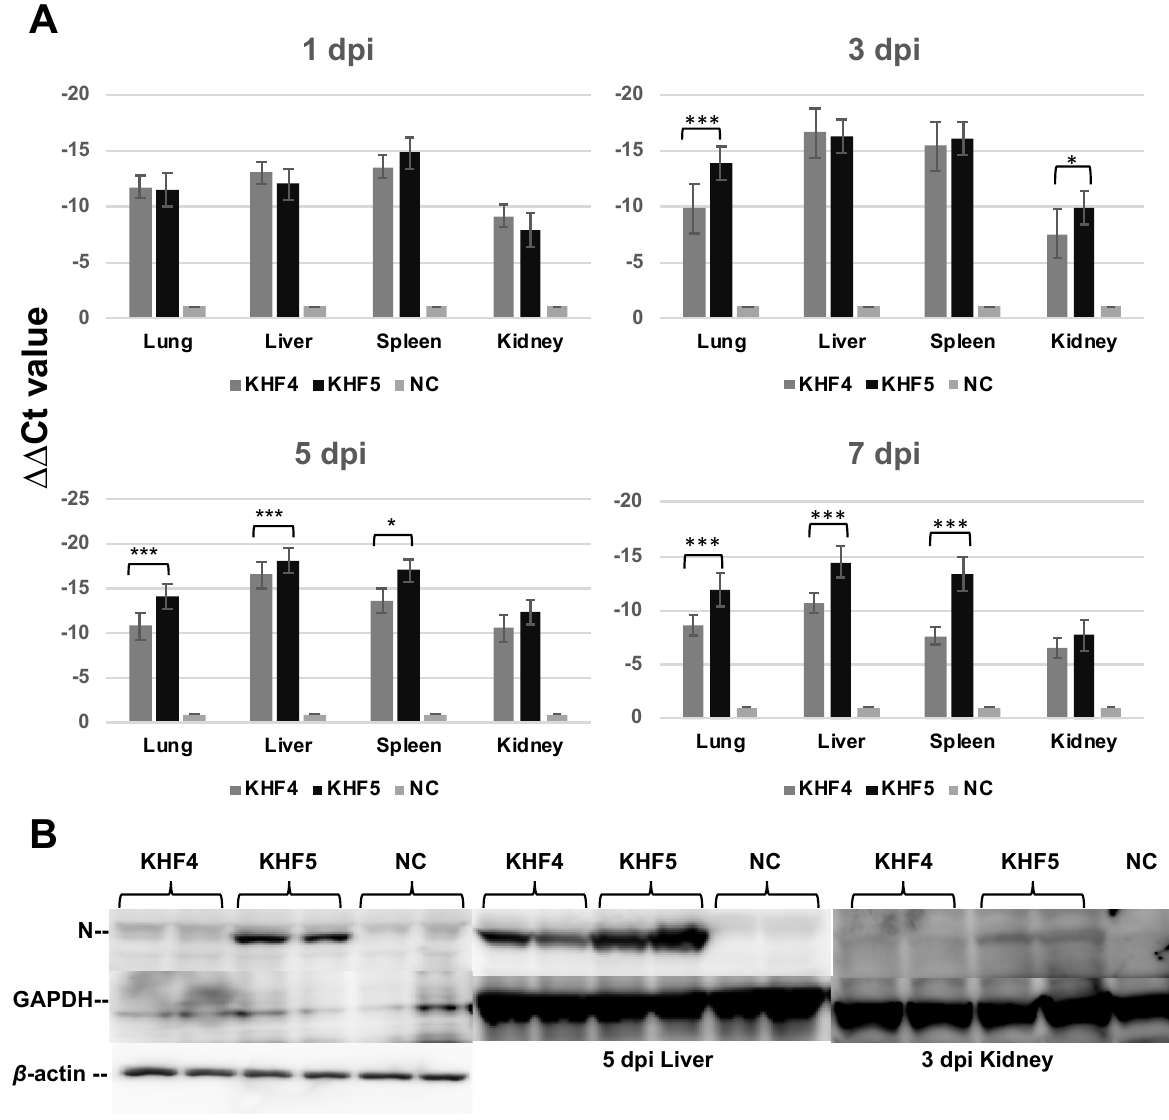
Figure 4. Viral replication in the lungs, liver, spleen, and kidneys. ( A ) Viral load in the four organs were quantified via real-time RT-PCR. The viral load was detected using S segment primer sets, normalized relative to β -2 microglobulin, and compared with the negative control ( ∆∆ Ct KHFV = (Ct KHFV S − Ct KHFV β 2M ) − (Ct NC S − Ct NC β 2M )) (Significance was assigned as * p < 0.05, and *** p < 0.001). ( B ) The anti-HTNV viral N protein was detected by Western blotting. Results from each pair of mice are